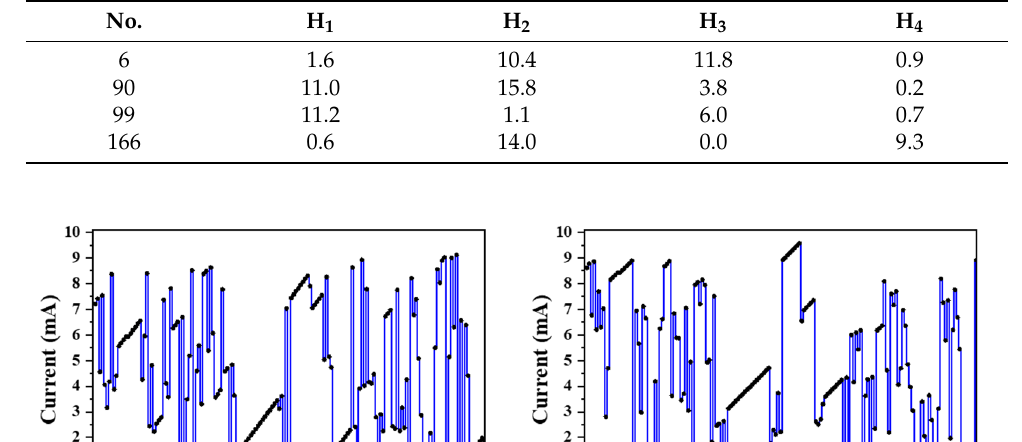
Table 1. Microheater power settings for different iteration (Unit: mW).